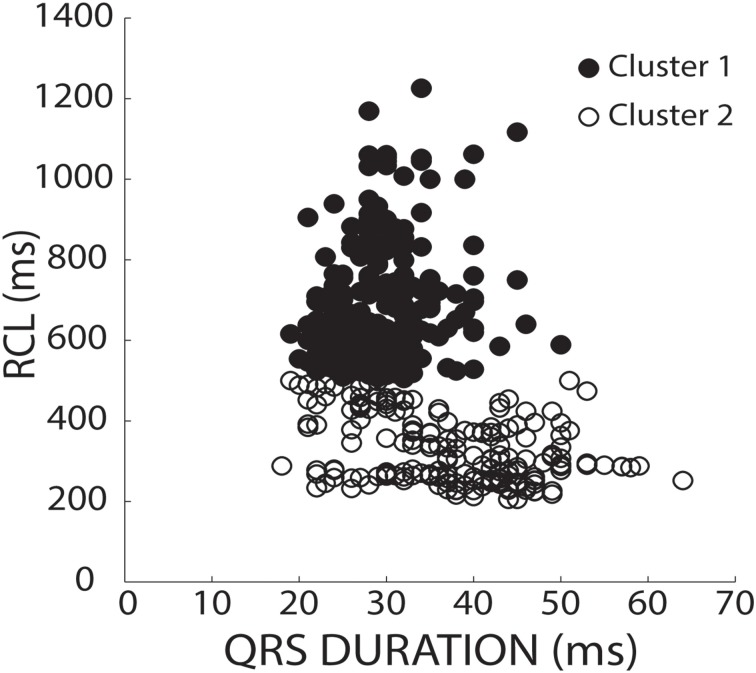
K-means separates clusters of raw values by RCL alone. RCL and QRS absolute values from all recovery beats are shown under both normal (37°C) and hypothermic (34°C) conditions from control, hypercalcemic, and digoxin conditions for both slow (200 bpm) and fast (375 bpm) pacing rates. Data was stratified into two clusters using a k-means clustering algorithm. As shown, the data preferentially separated in the RCL direction.